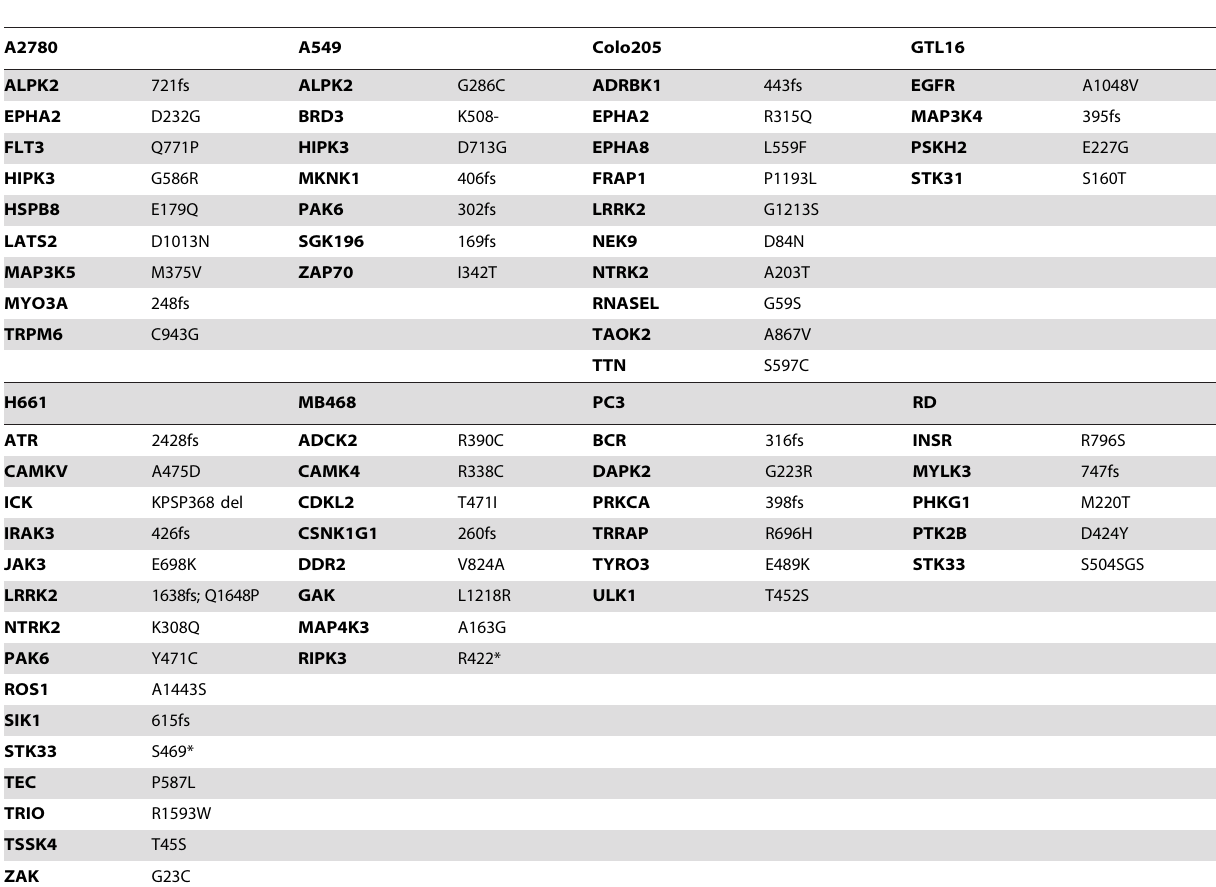
Table 5. High confidence* non-synonymous variants in protein kinase genes in each of 8